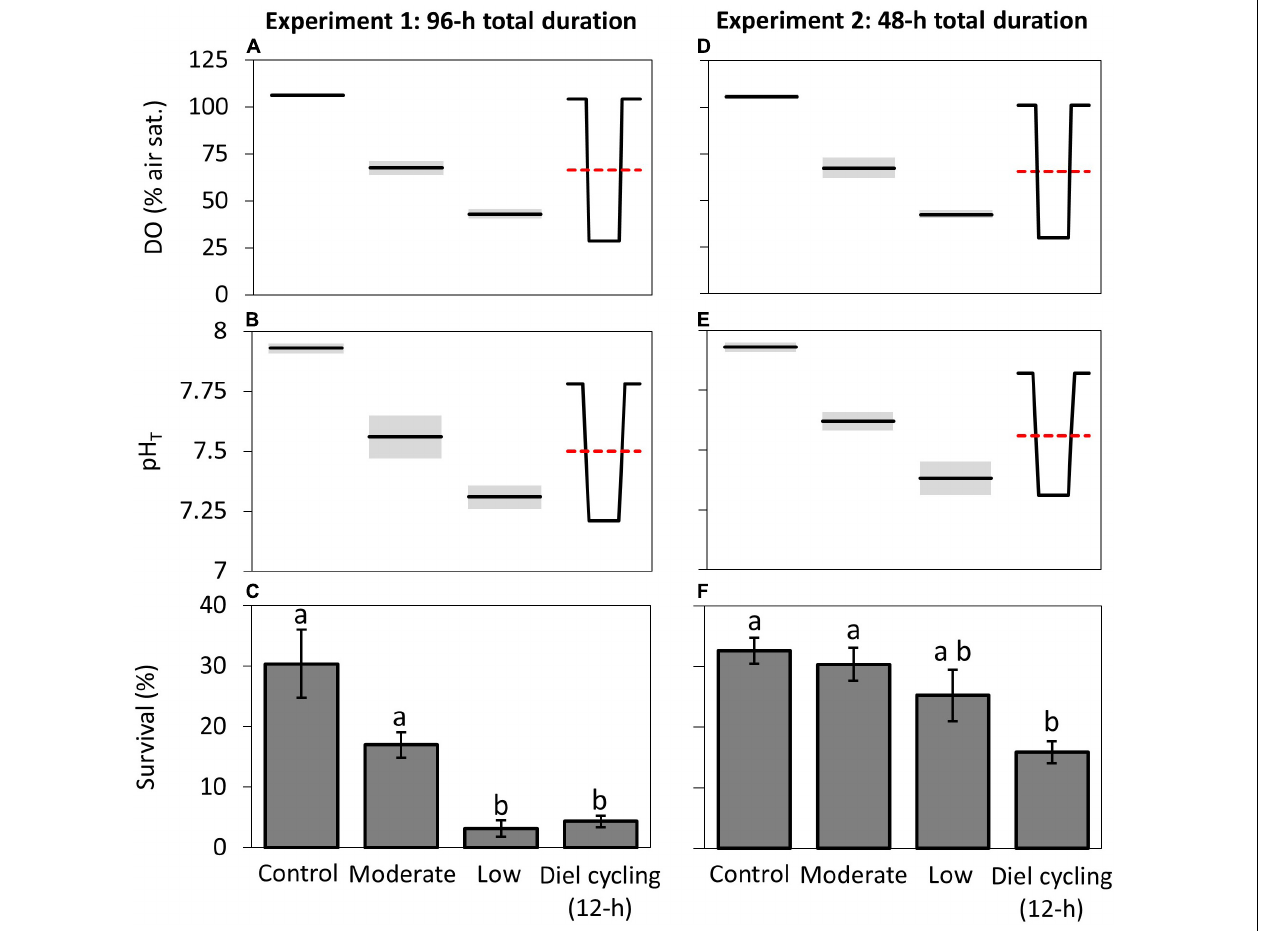
FIGURE 2 | Survival of Callinectes sapidus zoea I larvae under static and diel cycling DO and pH regimes for experiments one (96-h experiment) and two (48-h experiment). DO (A,D) and pH (B,E) values (see Supplementary Table 1 for all chemical values) for experiment one and two, respectively, diagrammed over a 24-h interval from three static treatments and one diel cycling treatment (fluctuating between 12 h of hypoxic/acidified conditions and 12 h of normoxic/normocapnic conditions every 24 h), for which shading represents the S.D. of static treatments and dotted lines represent average values of the diel cycling treatment. Average larval survival for experiment one (C) and two (F) , in which bars indicate means ( ± SE) and letters mark significant differences between treatments.